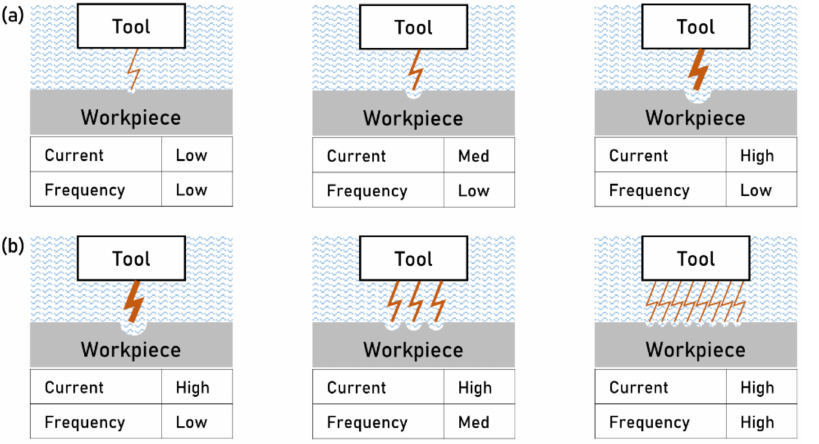
Figure 7. ( a ) Effect of current during sparking on surface finish, and ( b ) effect of frequency during sparking on surface